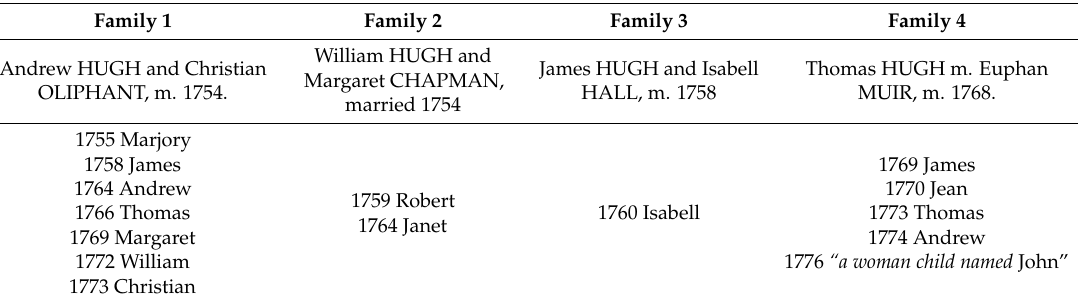
Table 4. HUGHES variant families reproducing Pittenweem